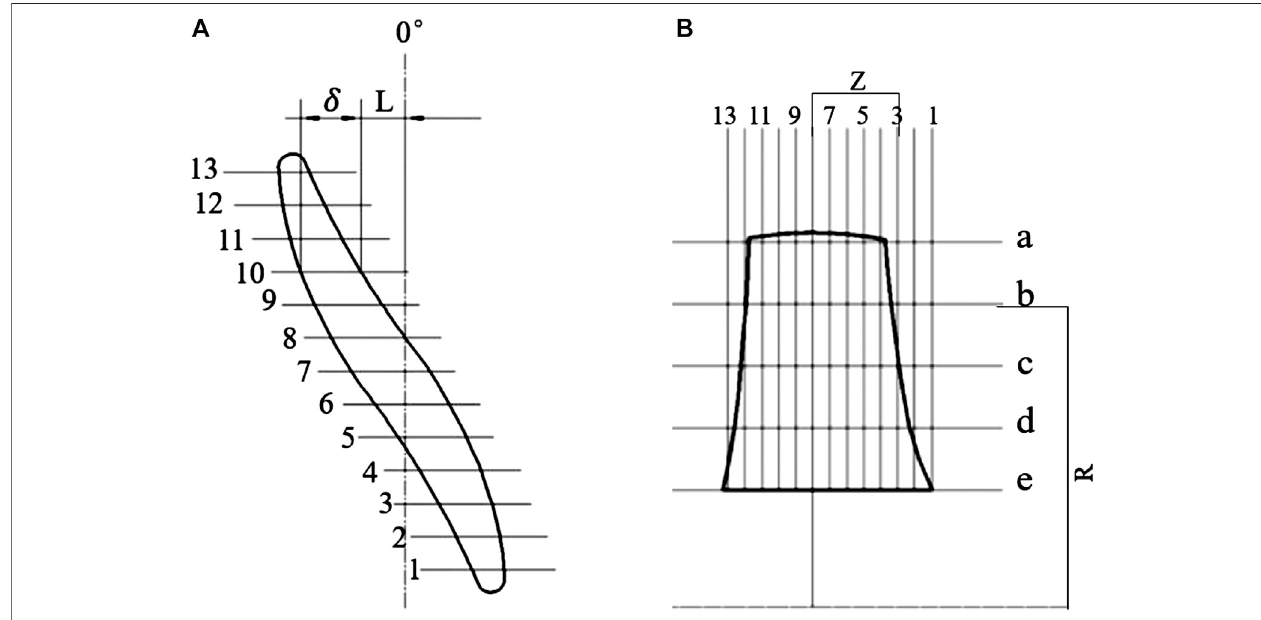
FIGURE 5 | "S"-shaped blade expansion view (A) and axial view (B)